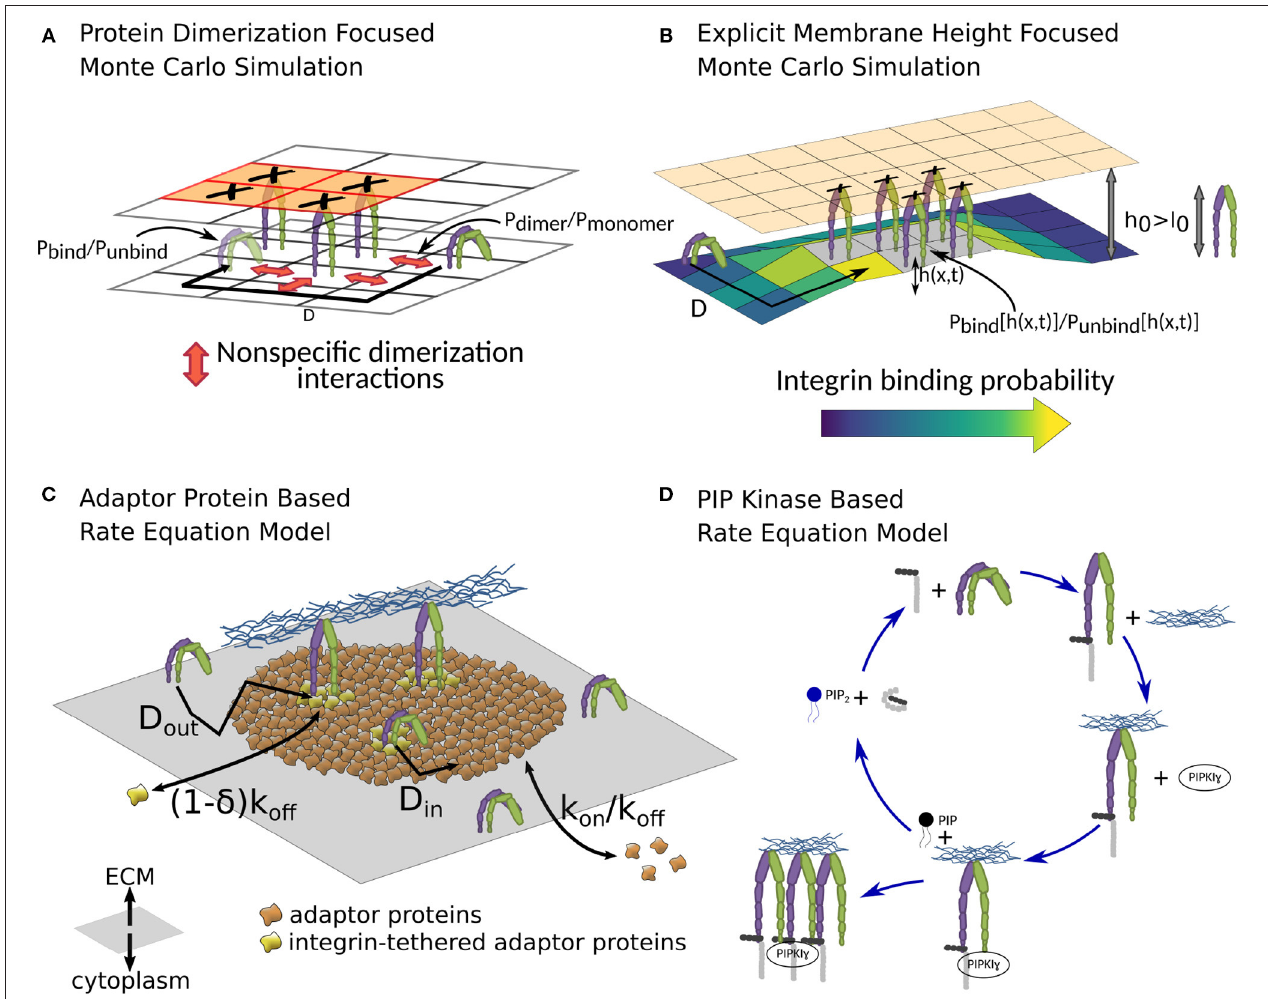
FIGURE 6 | Different theoretical models of the NA formation. (A) In the Monte Carlo simulation by Brinkerhoff and Linderman, dimerization interactions between integrins, as well as spatial ligand distribution patterns are studied ( Brinkerhoff and Linderman, 2005). They find that clustered ligand islands can increase integrin clustering, as dimerization interactions between immobile, ligand-bound integrins and mobile, unbound integrins can guide the latter toward unoccupied spots on the same ligand island. The lattice shown here is simplified compared to the one used in the publication for illustration purposes. (B) The coarse-grained Monte Carlo simulation in Fenz et al. (2017) allows a detailed look at one source of spatial integrin interaction, namely membrane and glycocalyx deformations (Fenz et al., 2017). Repulsions between cell and substrate, stemming among others from the shape and size of glycocalyx proteins, can result in a mismatch between the equilibrium separation of the two surfaces h 0 and the combined size of integrin and ligand l 0 . The initial bond formation therefore has to be accompanied by a membrane deformation, imposing an additional energy cost. After initial bond formation, however, the surrounding membrane is already partly deformed, reducing the energy cost of forming additional integrin-ligand bonds, which can locally increase the rate of bond formation by several magnitudes, as well as stabilize these bonds against dissolution. (C) MacKay and Khadra employ rate equations to study the NA formation (MacKay and Khadra, 2019). Here the NA is defined not by their integrin content, but solely by an area of cytoplasmic adaptor proteins, which, through stochastic binding and unbinding, build the backbone of the NA, the so-called adhesion plaque. Integrins inside the plaque can bind with the surrounding adaptor proteins, which stabilizes them against unbinding, allowing a sustained or even growing